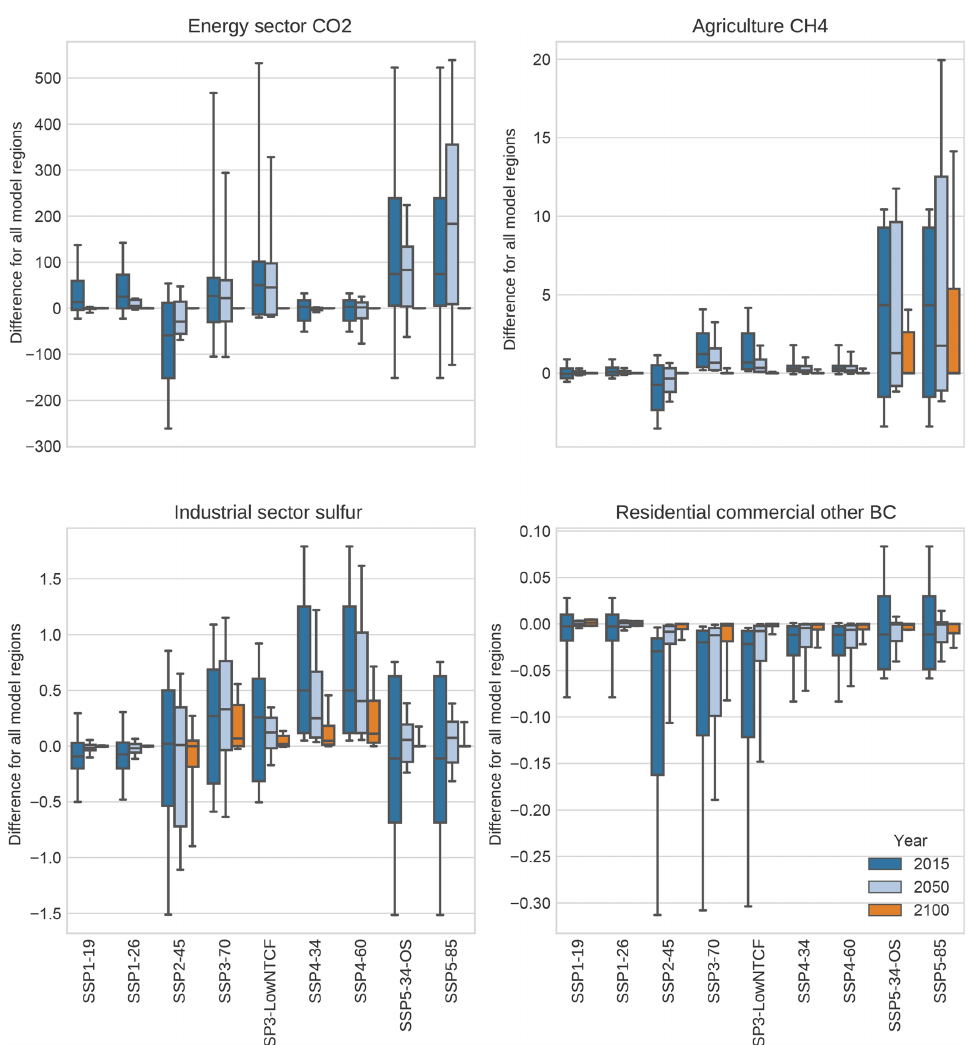
Figure F1. The relative difference between harmonized and unharmonized trajectories is shown for the primary sectoral contributor for various emissions species in each scenario. Boxes are comprised of the population of differences for all regions in a given model–scenario combination (see, e.g., Table 3). All box plots show upper and lower quartiles as solid boxes, median values as solid lines, and whiskers extending to the 10th and 90th percentiles. In general, the largest deviations are observed in the base year. The spread of values decreases in time across almost all observations, with the convergence to zero or near zero by